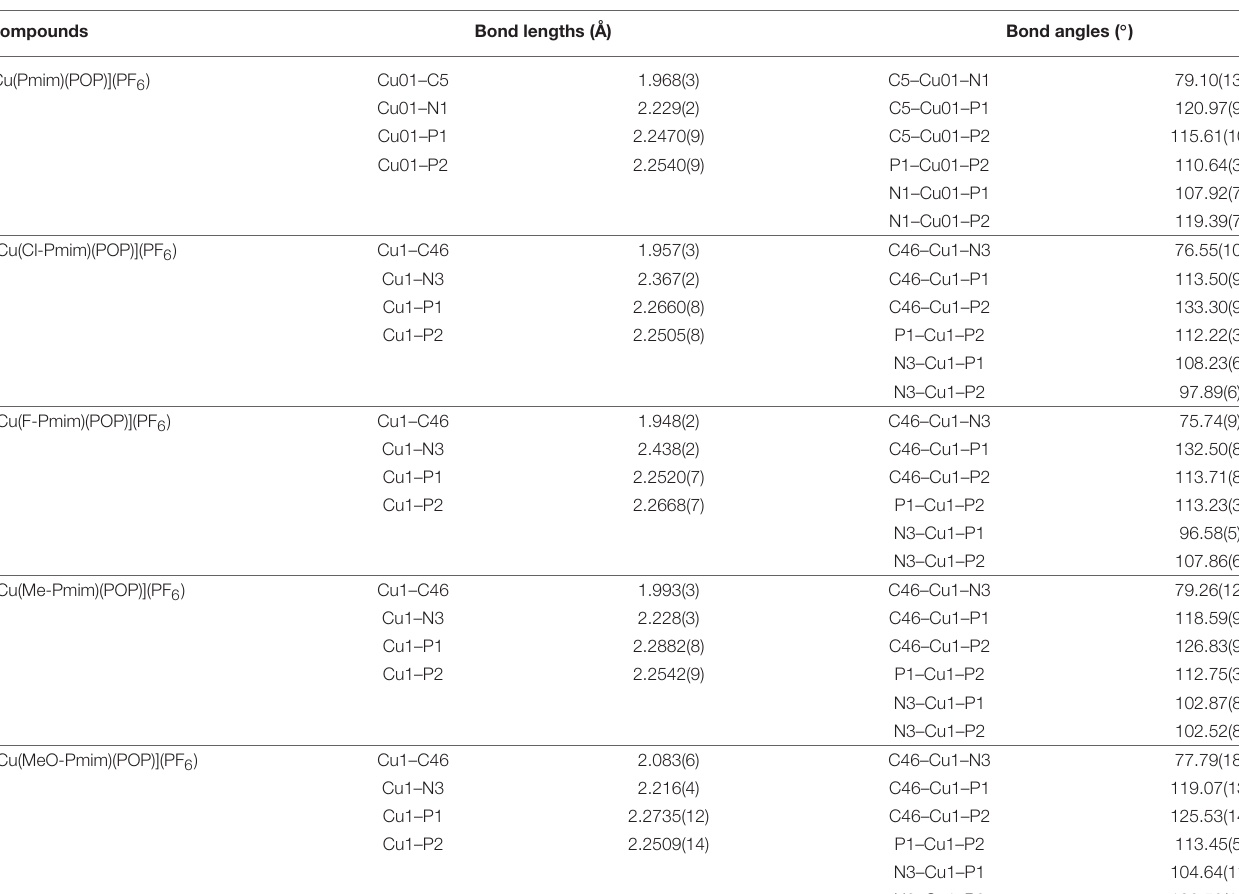
TABLE 1 | Selected Bond Lengths (Å) and Angles ( ◦ ) of the Cu(I)-NHC complexes. Compounds Bond lengths (Å) Bond angles ( ◦ ) [Cu(Pmim)(POP)](PF 6